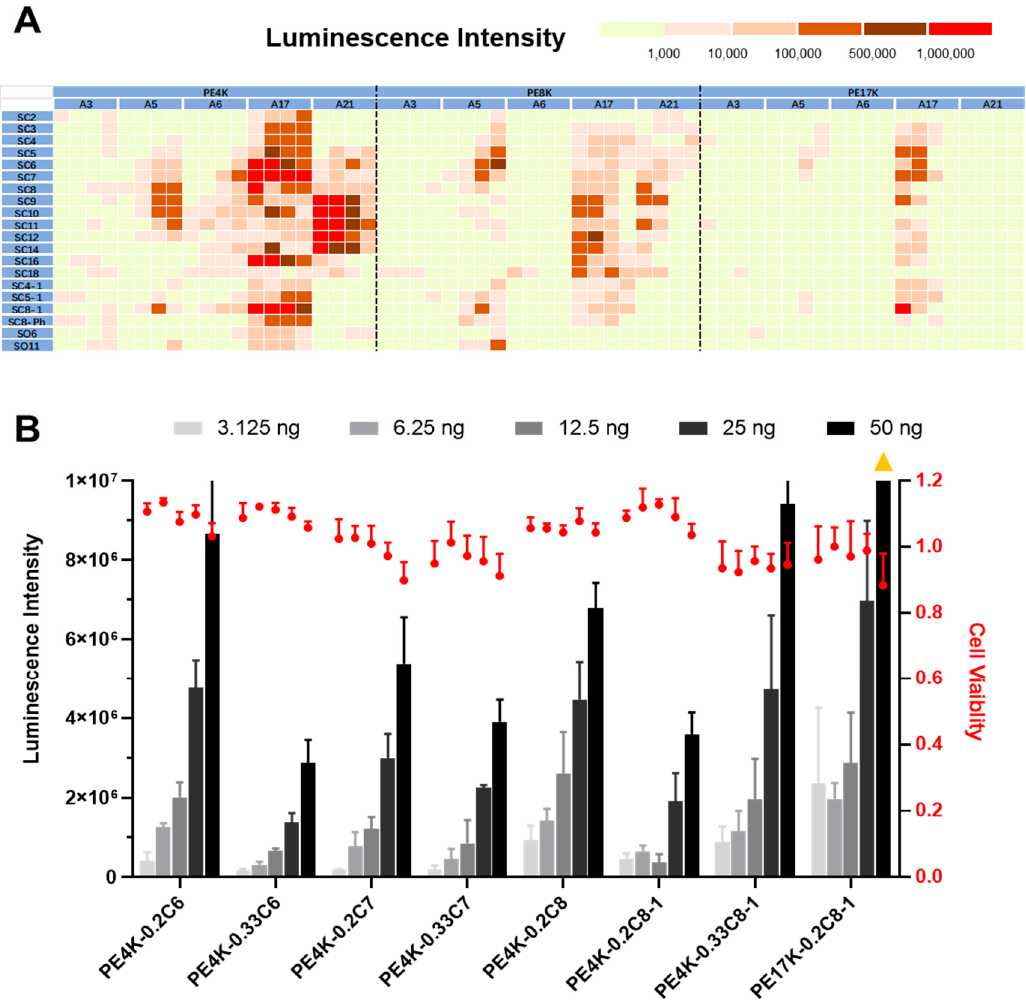
Figure 2. ( A ) Heatmap of in vitro screening of functional polyesters for luciferase mRNA (Luc mRNA) delivery to IGROV1 cells enabled identification of efficacious mRNA carriers. Each sub-column of corresponding amino thiols represent the SC:A molar feed ratios of 1:4, 1:2, 1:1, and 2:1. The Luc mRNA dose was 25 ng mRNA/well (181 pM). ( B ) Selected functional polyesters for Luc mRNA delivery efficacy and toxicity with dose response (mean ± s.d., n = 3; triangle symbol means over the range; all polyesters in B are A17 -modified).